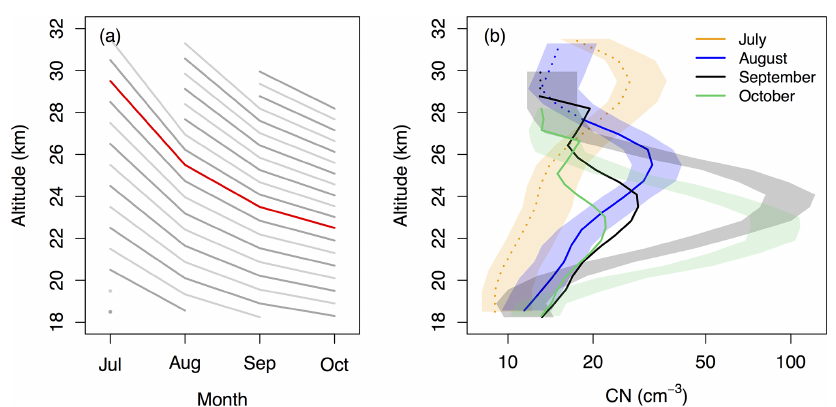
Figure 2. Air parcel subsidence trajectories (a) and simulated CN (monthly mean) without gaseous sulfuric acid being present (b) . The uncertainty ranges of the measured CN presented in Campbell and Deshler (2014) are shown as shaded areas in (b) for comparison. The trajectories of the simulated air parcels were placed around the subsidence of the measured CN maximum (red). In the simulation, the ambient conditions are kept constant during each month. For the first month of each trajectory, the CN concentrations (dotted) are chosen based on Campbell and Deshler (2014). In the following months, the simulated CN concentrations (solid) are the result of only coagulation and air volume compression, as there is no gaseous sulfuric acid present.